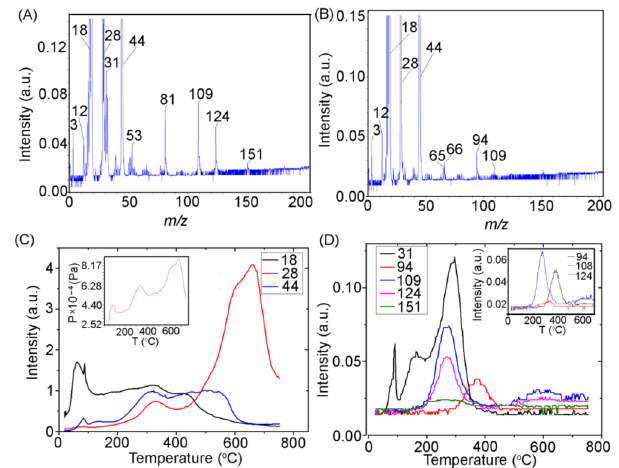
Figure 9. Thermal decomposition of VA/CeO 2 (0.6 mmol/g); mass spectra at 270 ◦ C ( A ) and 410 ◦ C ( B ); TPD-curves for ions with m / z 18, 24, 44, and vapor pressure measured as a function of temperature for the VA/CeO 2 sample ( C ); TPD-curves for ions with m / z 31, 94,109, 124, 151, and 182 and for ions with m / z 94, 108, and 124 ( D